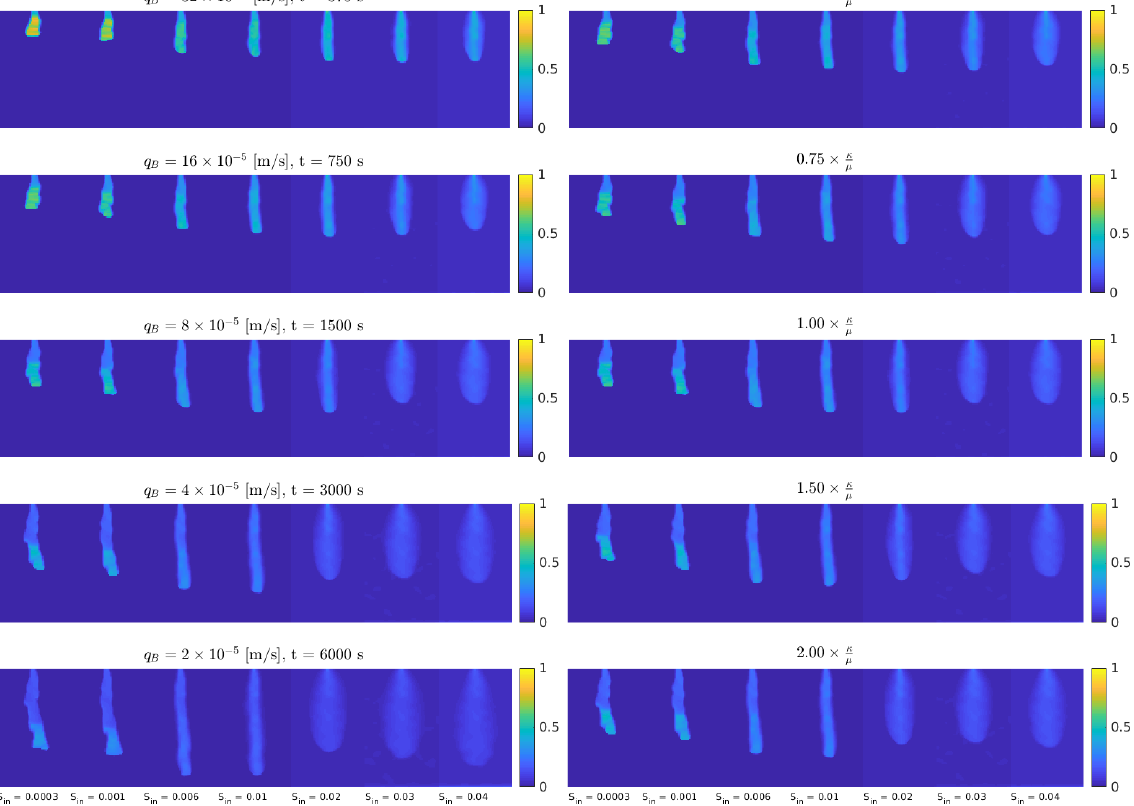
Figure B5. A snapshot of the saturation field for the intrinsic permeability distribution shown in Fig. B1a for seven different values of initial saturation S in and five different values of q B (left column) and for seven different values of initial saturation S in and five different values of b (right column). For the left column, times are scaled according to the boundary flux q B ; thus, a snapshot of the saturation field is shown at t = 100 , 50 , 25 , 12 . 5, and 6 . 25min for q B = 2 , 4 , 8 , 16, and 32 × 10 − 5 ms − 1 , respectively. For the right column, times are given at